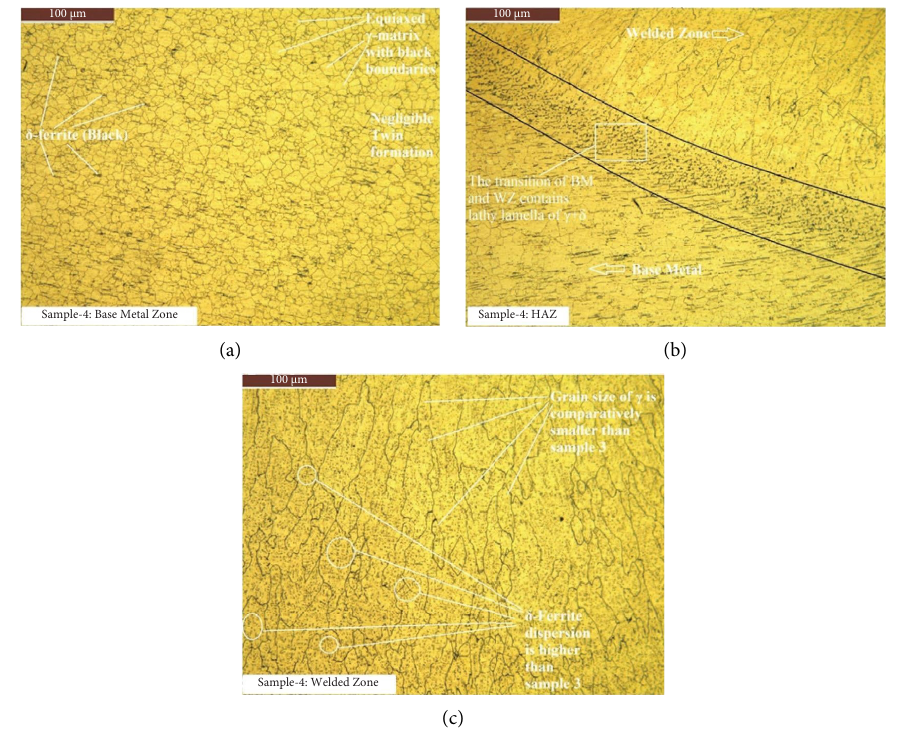
Figure 8: Microstructural appearance of sample 4 (water+air-cooled): (a) the base metal, (b) HAZ, and (c) welded